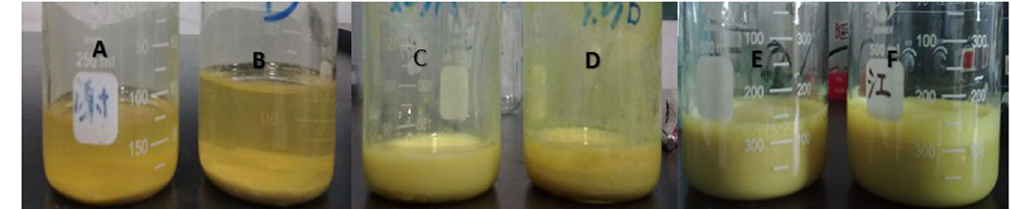
Figure 1. The stability of cyadox nanosuspension prepared with different stabilizer. (A) Poloxamer 407; ( B ) Poloxamer 188; ( C ) Sodium alginate; ( D ) Pluronic ® F-68; ( E) Polyvinyl pyrrolidone; ( F) Polyvinyl alcohol.